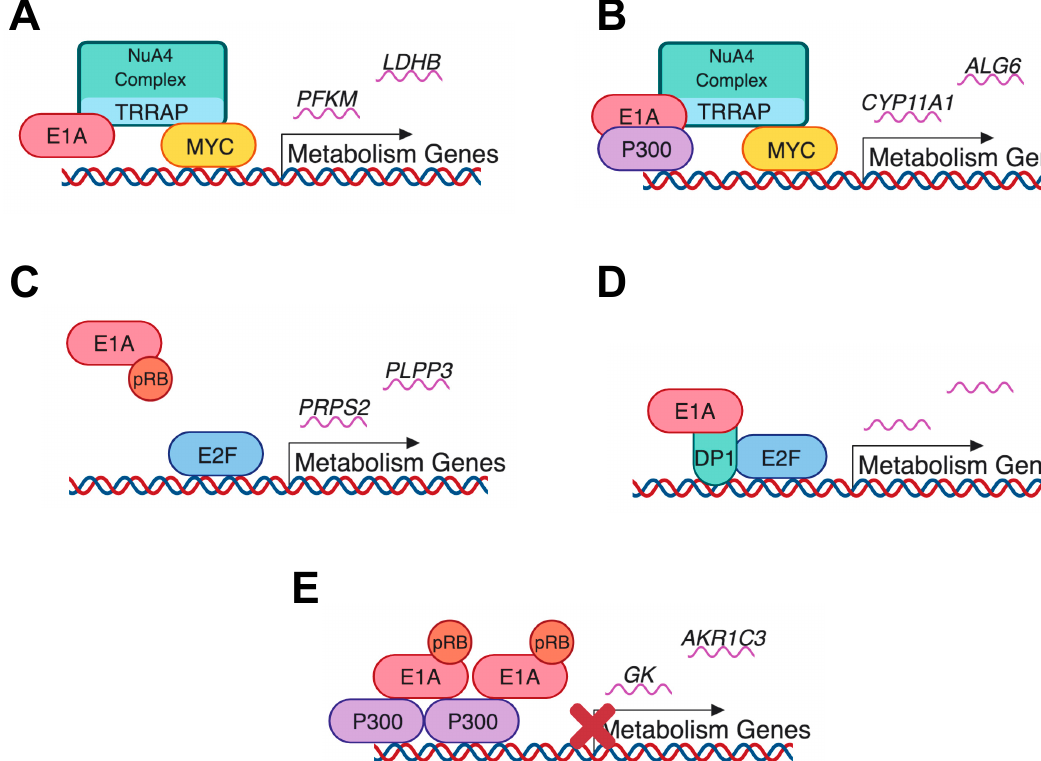
Figure 6. Putative mechanisms by which HAdV E1A regulates transcription of host-cell metabolic genes based on models derived from the literature [49–51]. ( A ) E1A can regulate metabolic gene expression through an interaction with the transcription factor MYC. E1A binds TRRAP, part of the NuA4 complex, which in turn is bound to MYC leading to increased transcription of metabolic genes [49]. PFKM and LDHB are two examples of transcripts that may be regulated due to this interaction based on supplementary data from Zhao et al. [49]. ( B ) The same paper indicated that E1A may be bound to p300 in addition to TRRAP and MYC leading to the expression of other E1A-regulated genes [49]. Again, CYP11A1 and ALG6 are two examples of metabolic genes potentially regulated by this interaction based on supplementary data from Zhao et al. [49]. ( C ) E1A can bind to pRB and release the inhibition of E2F-mediated gene transcription by pRB [51]. PRPS2 and PLPP3 are examples of two metabolic genes whose expression are decreased in a HAdVC-5 infection with a non-pRB binding E1A mutant compared to wild type infected cells and therefore could rely on the pRB-binding of E1A for expression during infection [51]. ( D ) E1A may also mediate the expression of E2F regulated genes through an interaction with DP1, which itself can bind to E2F and activate transcription [50]. No specific transcripts are shown, as this study by Pelka et al. did not include an RNA-seq component [50]. ( E ) Finally, an interaction between E1A, p300 and pRB may inhibit transcription of metabolism related genes through histone deacetylation [51]. GK and AKR1C3 are two genes that may be regulated by E1A binding to p300 [51]. Image created with BioRender.